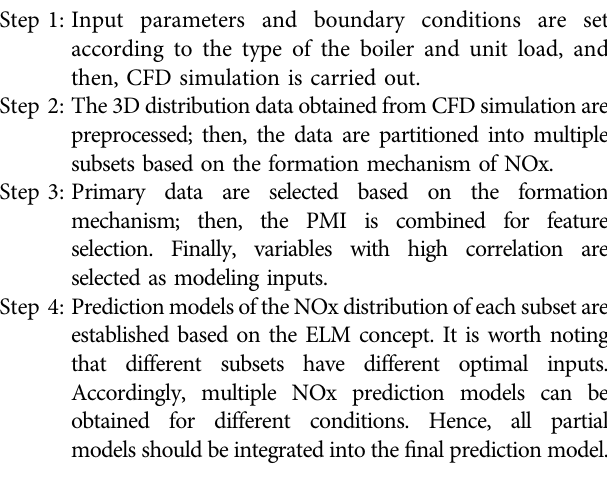
Frontiers in Energy Research |